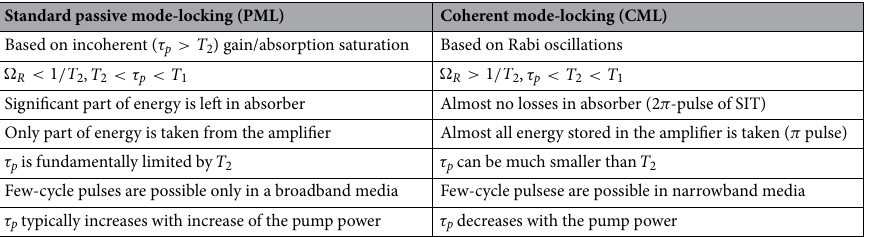
Table 1. Standard (incoherent) passive mode-locking (PML) and coherent mode-locking